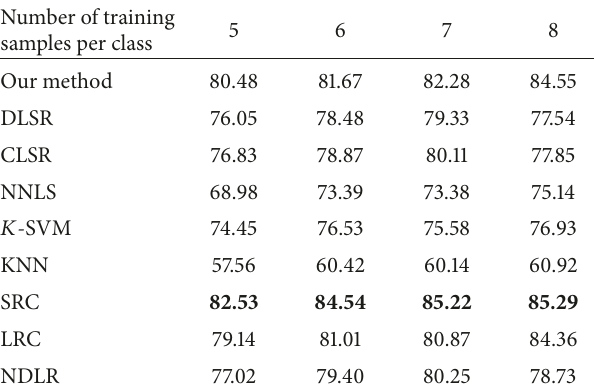
Table 5: Accuracies (%) of different methods on the YaleB database. Number of